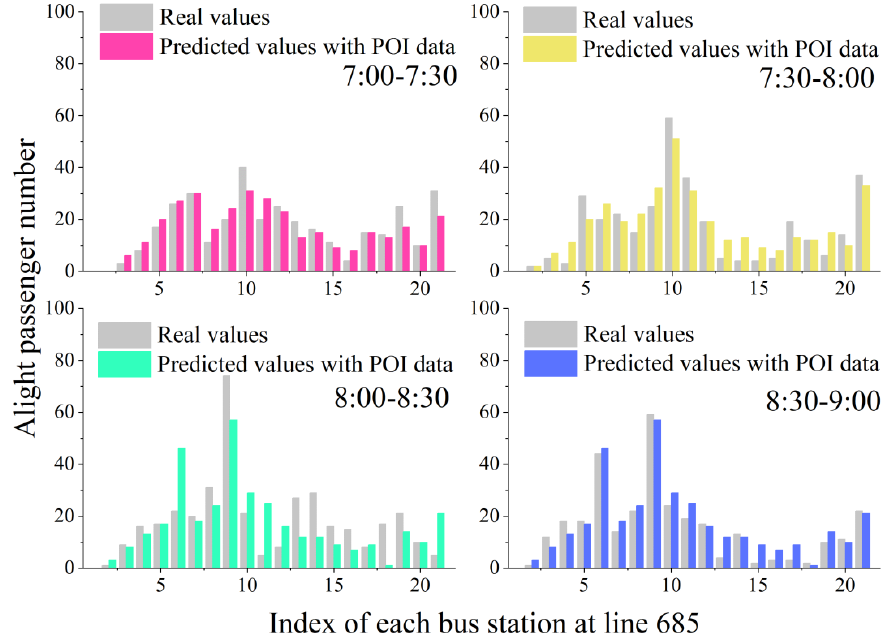
Figure 6. Prediction and true values of alighting passenger numbers for line 685 .